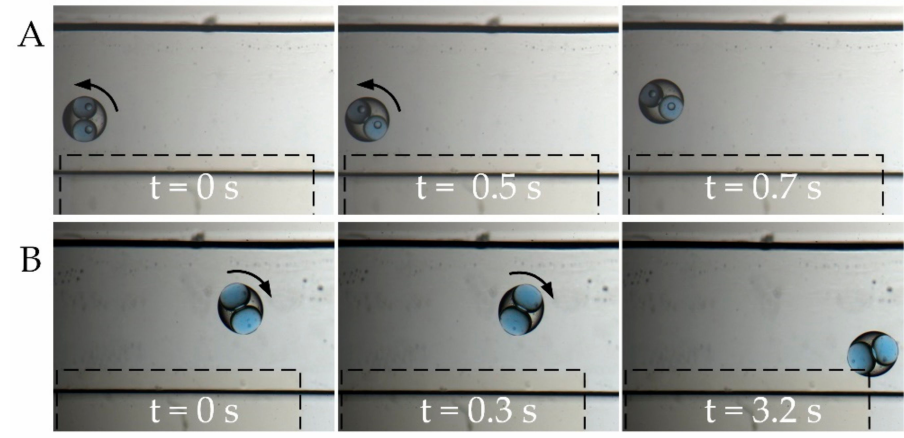
Figure 6. DEP response of droplets with two cores (Movie S3). ( A ) Negative DEP response with low core conductivity, 15 mS / m; ( B ) Positive DEP response with high core conductivity, 1.5 S / m. Scale bar, 300 µ